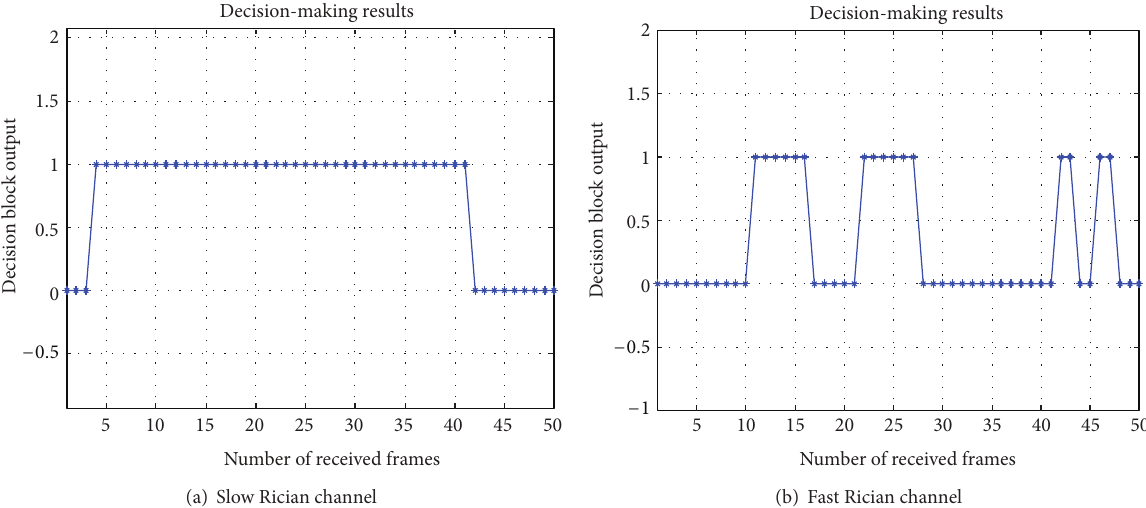
F 7: Decision-making results for the Rician channel; “1”